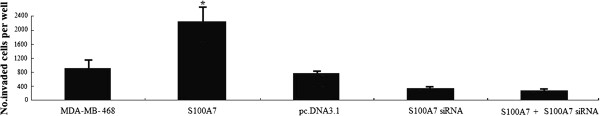
Effect of S100A7 overexpression on invasiveness of MDA-MB-468 cells transfected with recombinants in Matrigel invasion assay. Cells were stably transfected with empty vector pc.DNA3.1 or pc.DNA3.1-S100A7, or transfected with S100A7 siRNA. After 2 days, 1 × 105 cells were allowed to invade through transwell inserts (8 μm) coated with Matrigel. The cells on the lower surface of the chambers were stained, counted, and photographed under a light microscope. Histogram shows invasive capability of transfected cells. Each bar represents mean ± SE (n = 3); *, P <0.05.